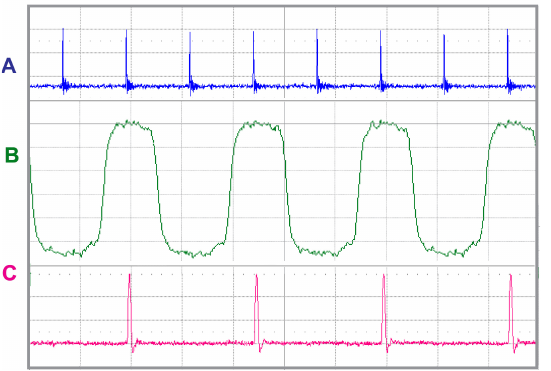
Figure 19. A—Train of pump laser pulses, repetition rate f p = 82.2 MHz. B—modulating pulses with repetition rate f p /2, signal is derived from the pump laser pulses, C—Train of OPO pulses after the division by two and appropriate delay, repetition rate f p /2 = 41.1